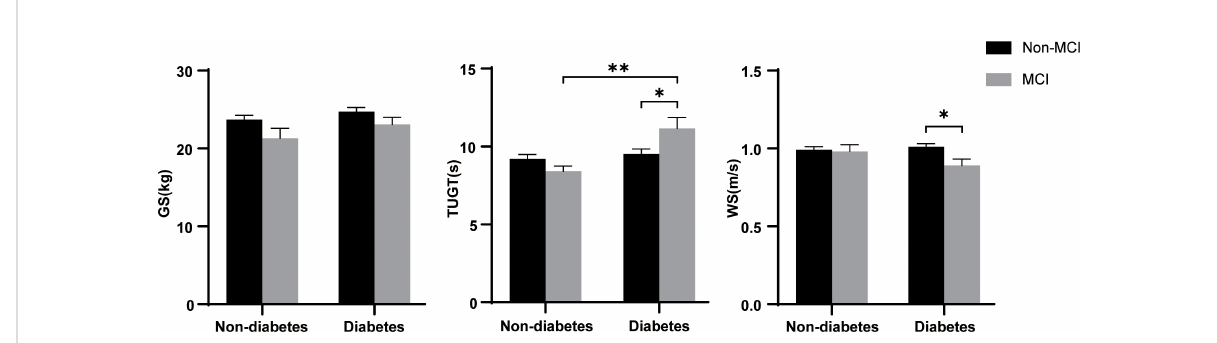
FIGURE 2 Difference of physical performance between the different groups. GS, grip strength; TUGT, Timed Up and Go Test; WS, 4-m walking speed; MCI, mild cognitive impairment. Data are presented as mean ± SD using t test. * represents p < 0.05, ** represents p <